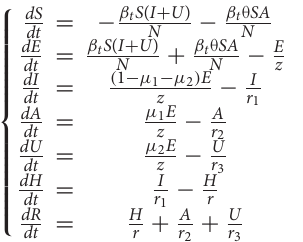
of confirmed symptomatic, asymptomatic, and unconfirmed symptomatic cases, respectively; and r was the duration from hospitalization to recovery or death. Assume that N = S + E + I + A + U + H +